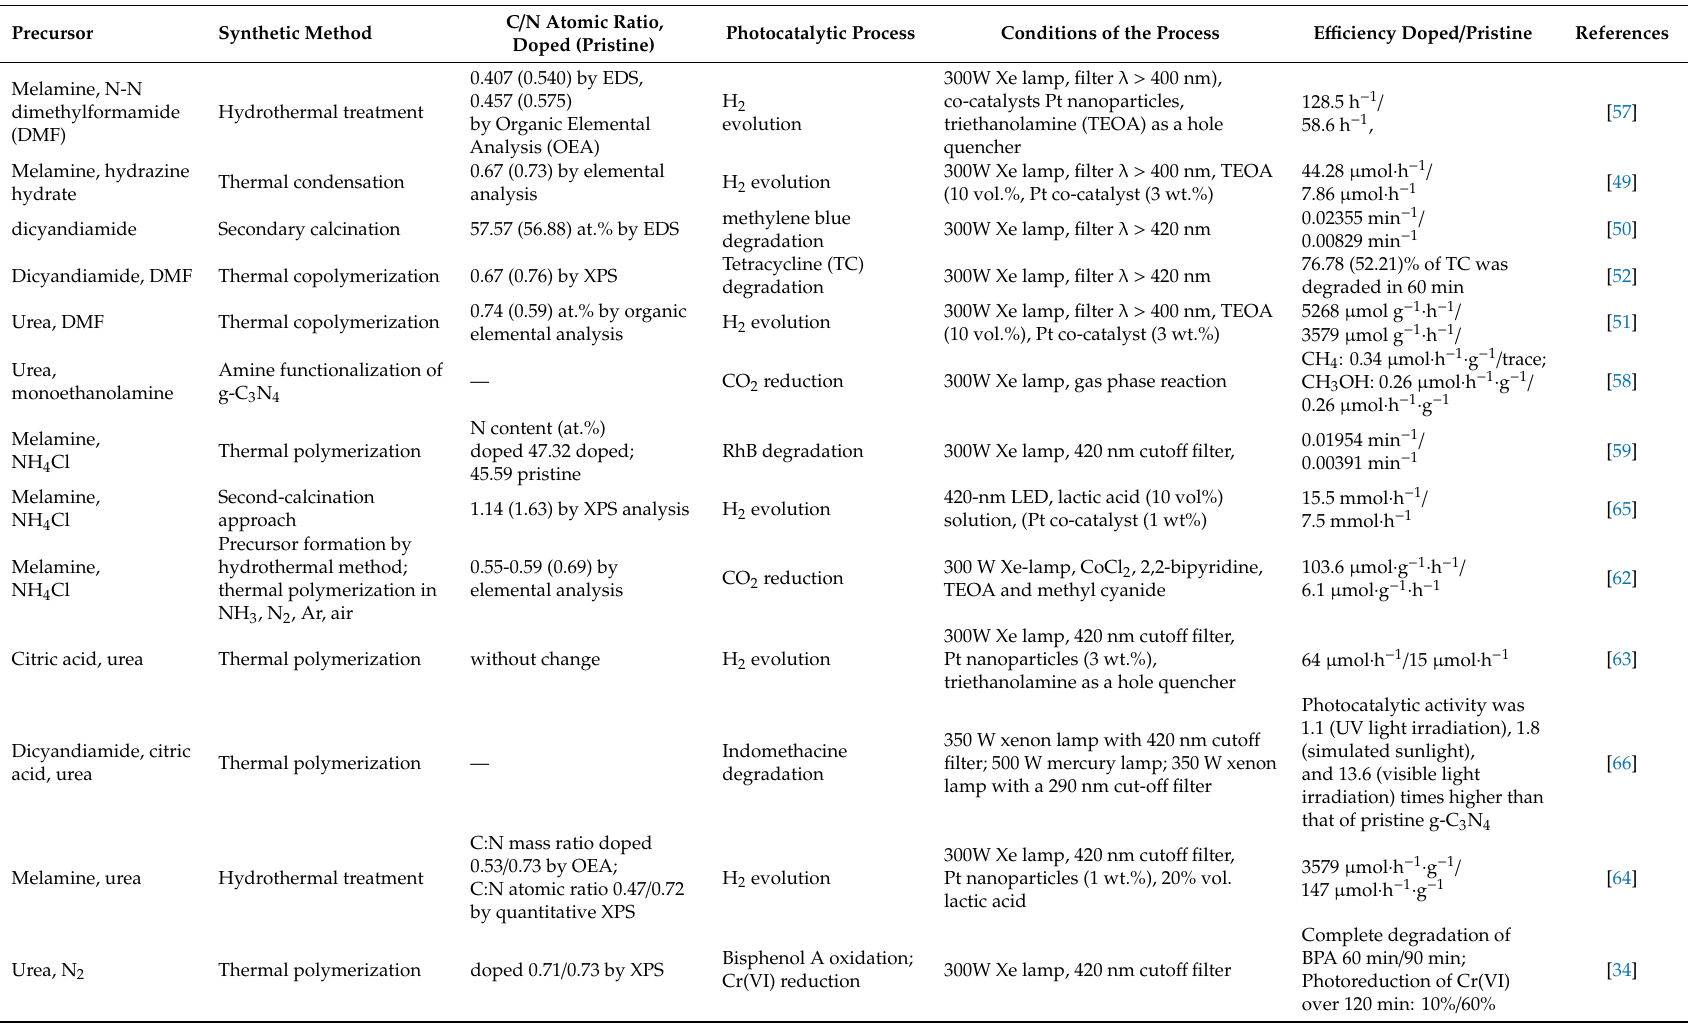
Table 2. Synthetic methods, applications, and photocatalytic e ffi ciency of N-doped g-C 3 N 4